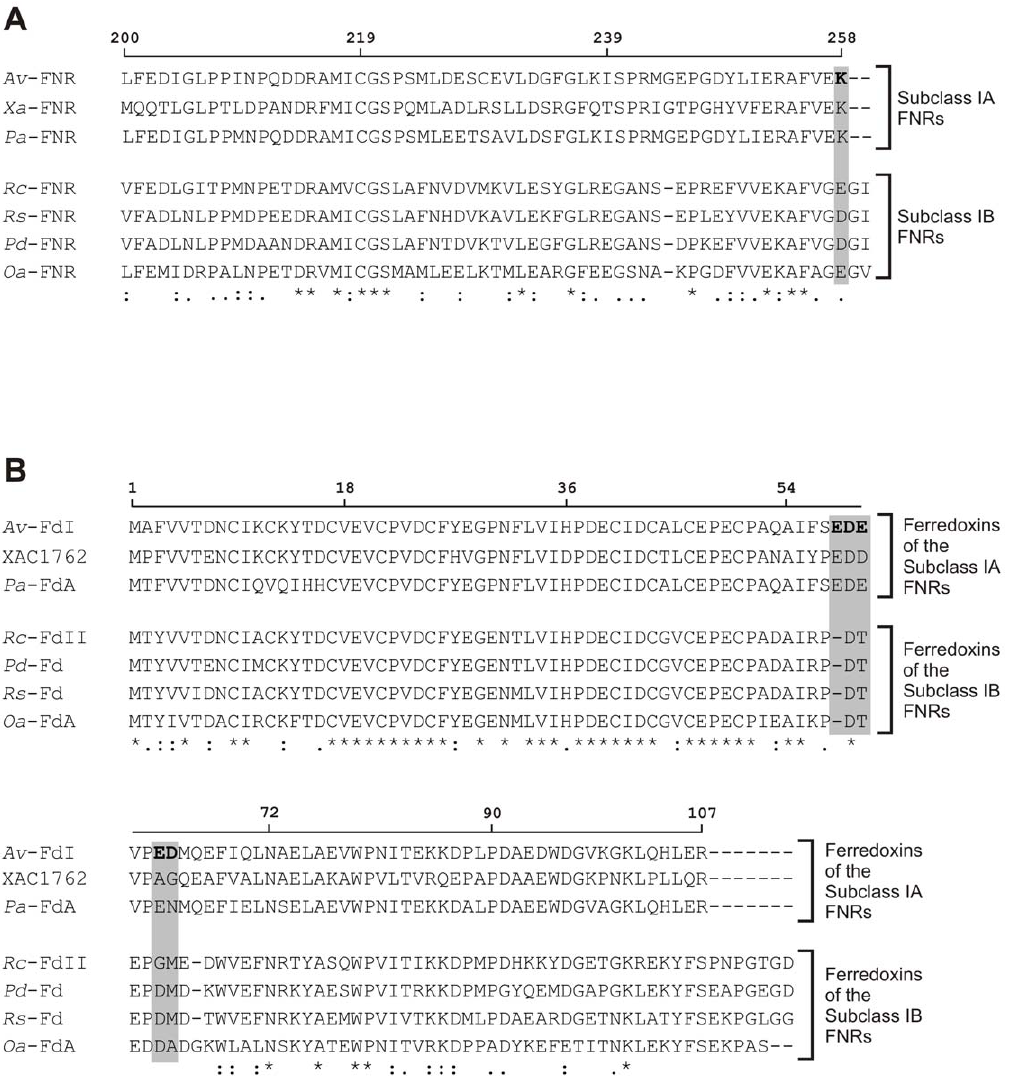
Table 3. X. axonopodis pv. citri cells were grown aerobically in Silva